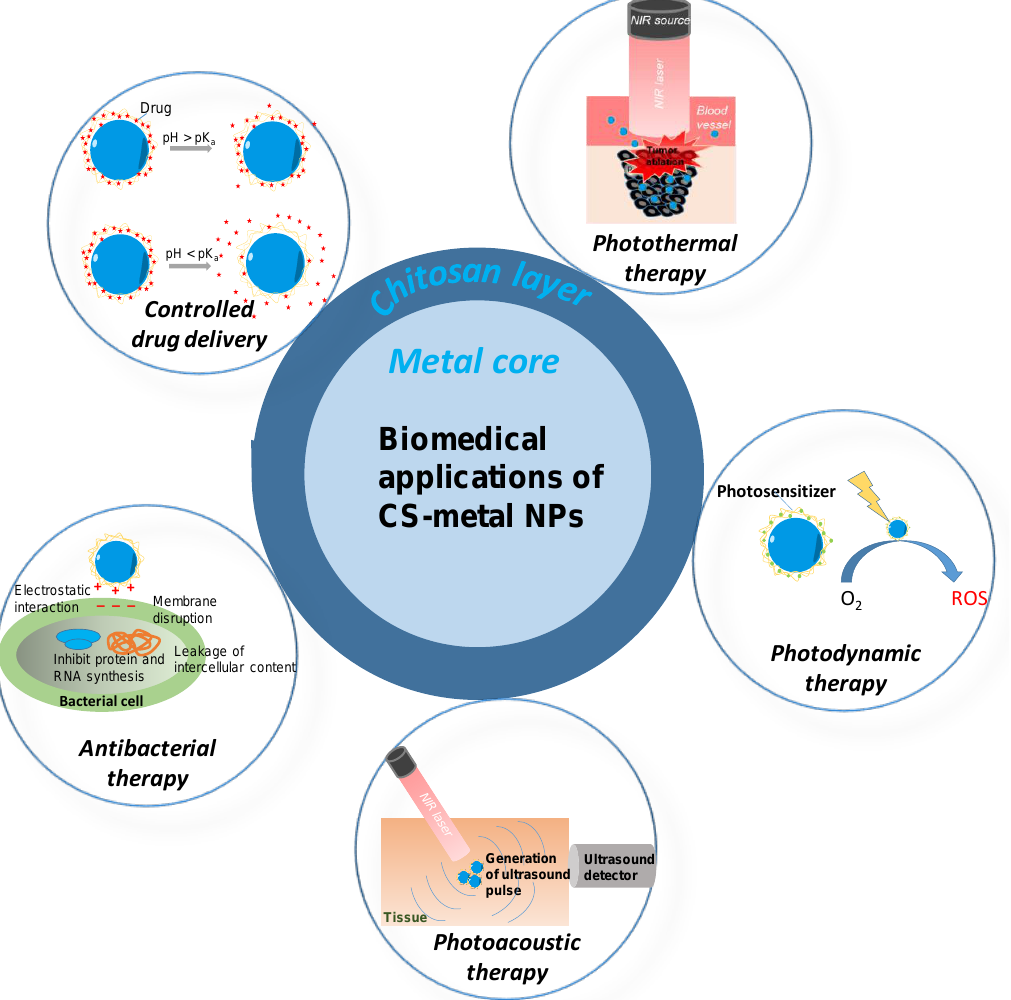
Figure 5. The biomedical application of CS-metal nanoparticles.